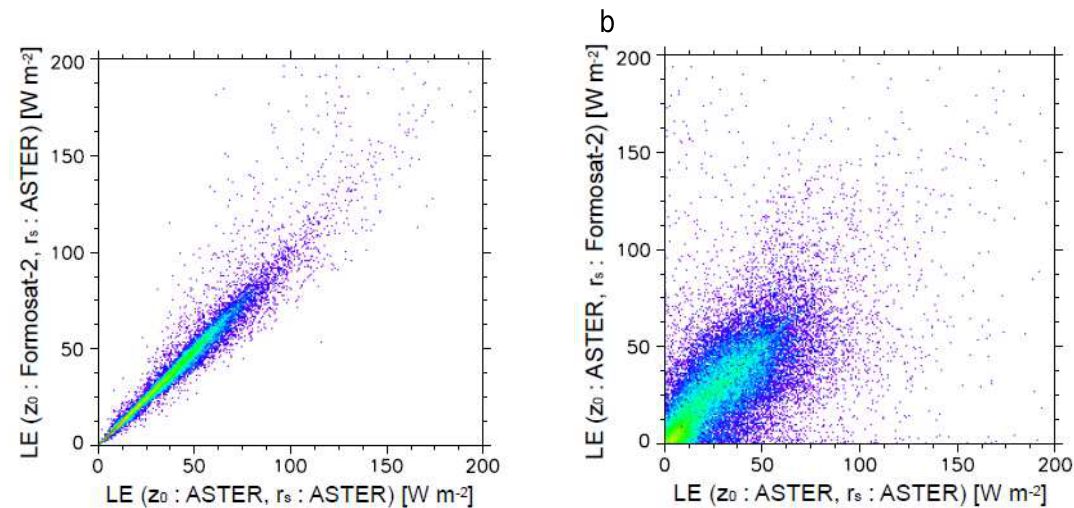
Figure 9. Scatterplots of storage heat flux, D G , estimated from ASTER vs. a) storage heat flux estimated based on the roughness length from Formosat-2 and the minimum stomatal resistance from ASTER, and b) storage heat flux estimated based on the roughness length from ASTER and the minimum stomatal resistance from